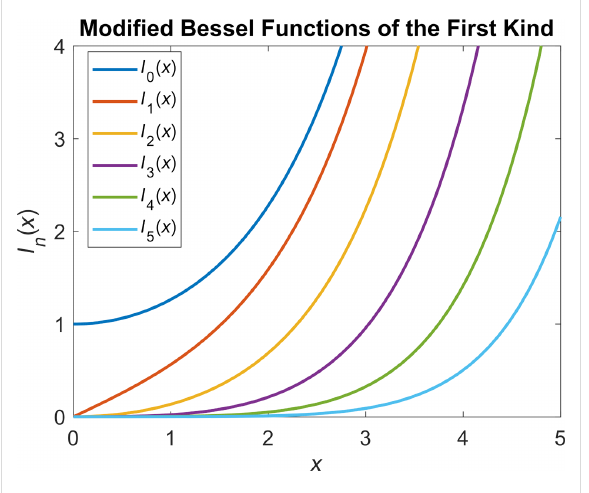
Figure 2: Modified Bessel functions of the first kind of different orders. While the zeroth-order function approaches unity at the origin, higher- order functions approach zero quite steeply. Higher-order functions converge to zero more quickly than their lower-order counterparts as the origin is approached from the